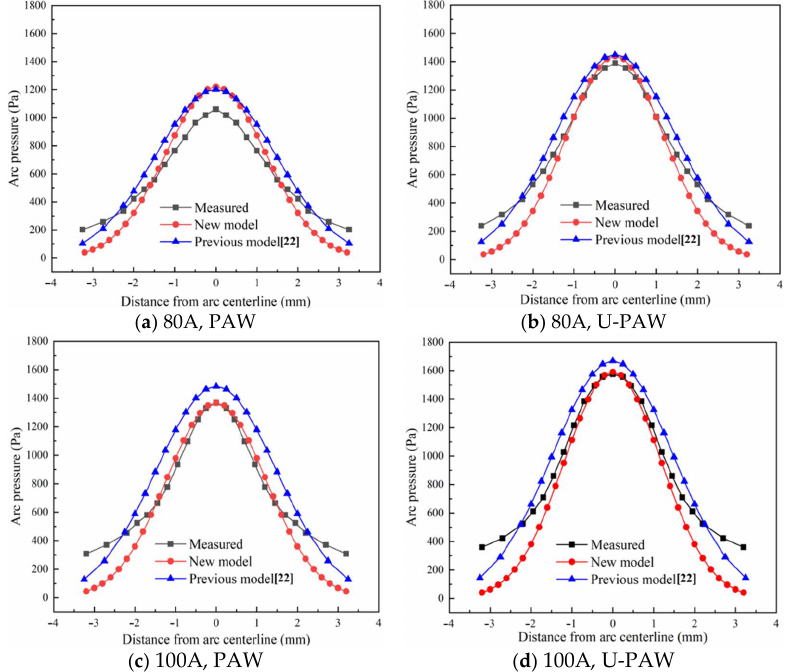
Figure 2. Plasma arc pressure distribution. Table 1. The used welding parameters.